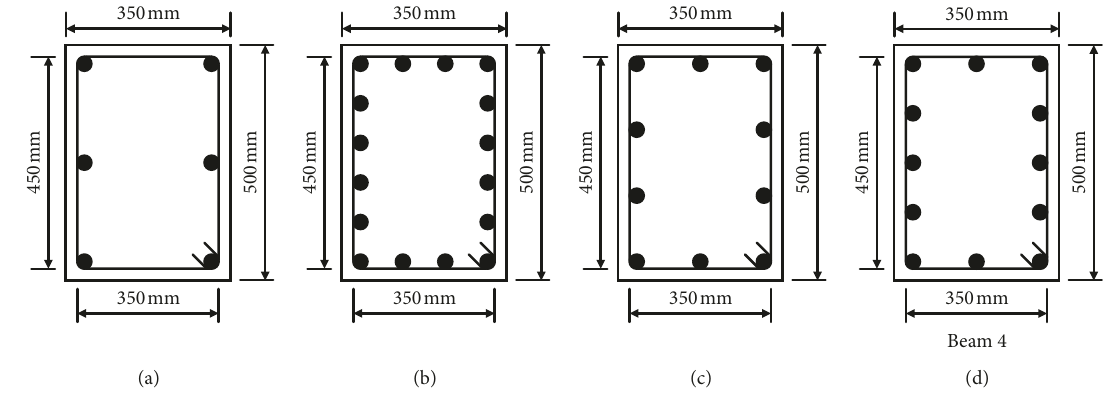
Figure 10: Typical reinforcement layout: (a) Beam 1. (b) Beam 2. (c) Beam 3. (d) Beam 4.